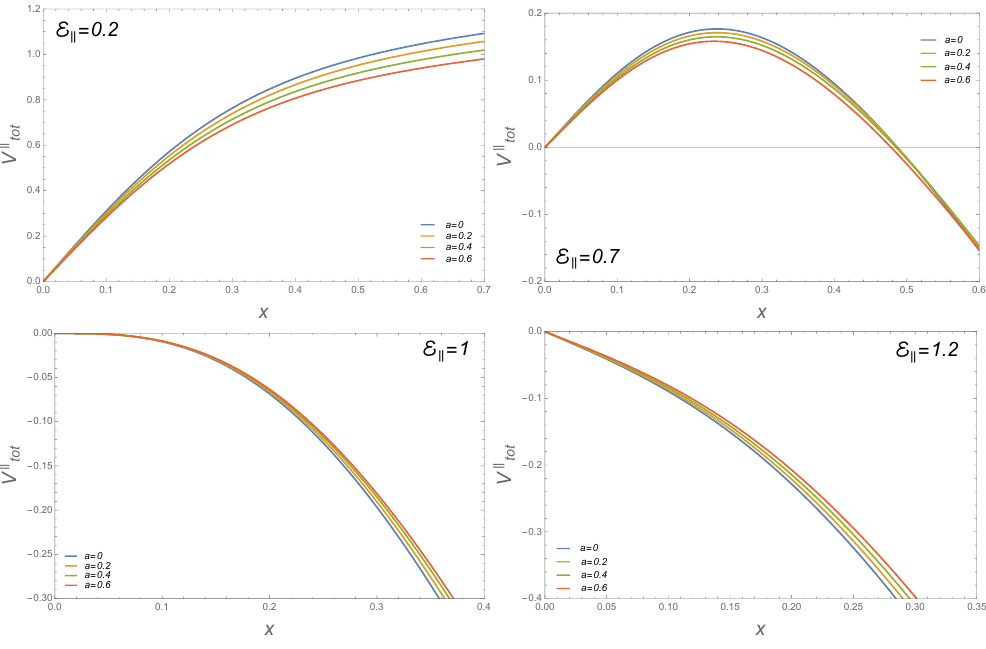
Figure 6 . The holographic potential V k fixed E in the bubble background. k